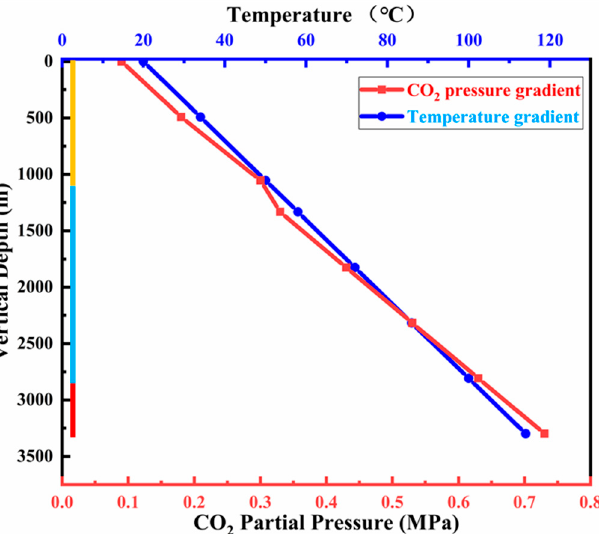
Figure 1. Temperature/partial pressure-well depth profile chart. Note: The meaning of longitudinal axis color division, yellow area represents low temperature formation; the blue area represents the medium temperature stratum; the red area represents high temperature strata.